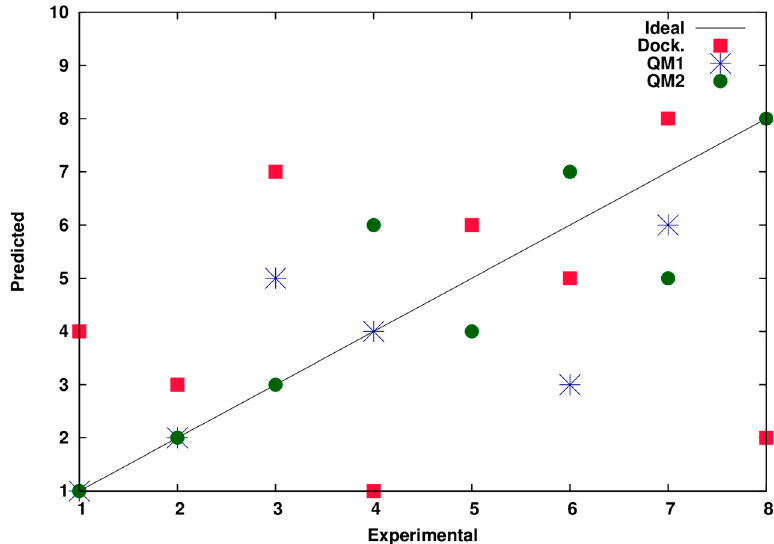
Figure 1. Experimental vs. predicted inhibitor potency. X -axis: experimental score, y -axis: theoretical score. Red squares-after the docking; Blue stars-after the docking and QM SP energy calculation (M062X/6-31g(d)); Green dots-after the docking, MM minimization and QM SP energy calculation (M062X/6-31g(d)).